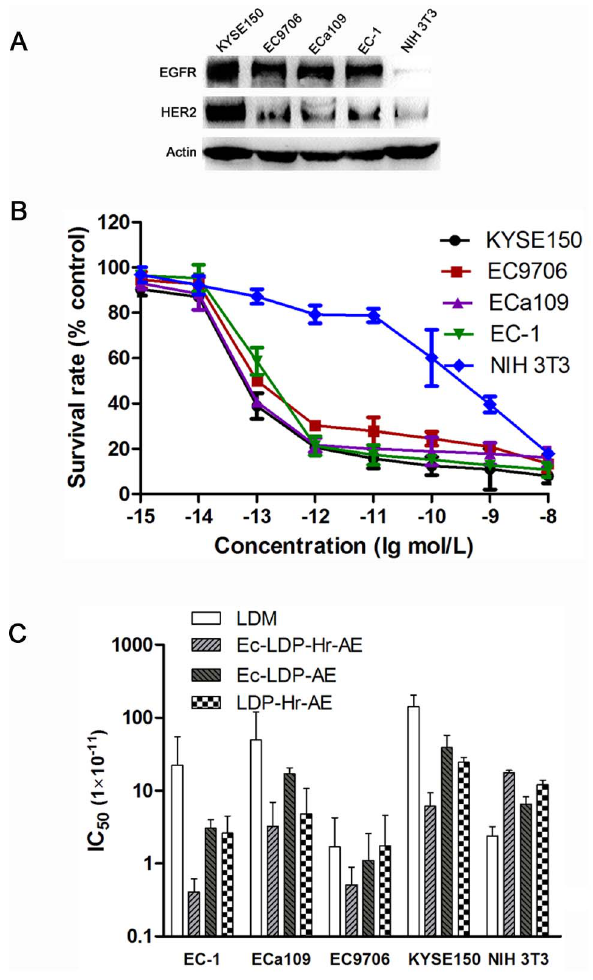
Figure 2. Cytotoxicity of Ec-LDP-Hr-AE on esophageal cancer cells. (A) Expression of EGFR and HER2 on different esophageal cancer cells and NIH 3T3 cells analyzed by Western blot. (B) The cell killing effects of Ec-LDP-Hr-AE on esophageal cancer cell lines KYSE150, EC9706, ECa109 and EC-1and mouse fibroblast cell line NIH 3T3 were tested by MTT assays. Cells were exposed to various concentrations of Ec-LDP-Hr-AE for 48 h and the results were obtained from three independent experiments. (C) The IC 50 values of lidamycin (LDM), Ec- LDP-Hr-AE, Ec-LDP-AE, and LDP-Hr-AE against 4 kinds of esophageal cancer cells and NIH 3T3 cells were measured by MTT assay. Columns, mean of triplicate experiments, bars, SD. doi:10.1371/journal.pone.0092986.g002 the exposure dosages of 0.5 nmol/L and 1 nmol/L of Ec-LDP- Hr-AE (P , 0.05, Fig. 4D).